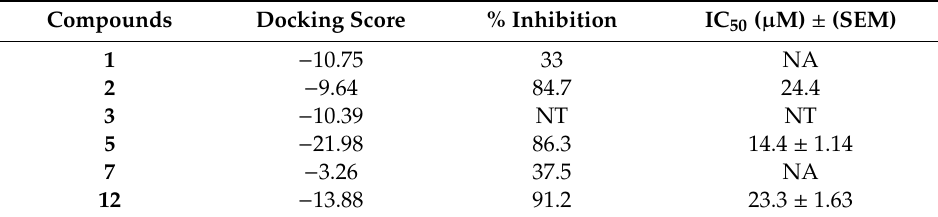
Table 4. The anti-CA-II activities of compounds 1 , 2 , 5 , 7 , and 12